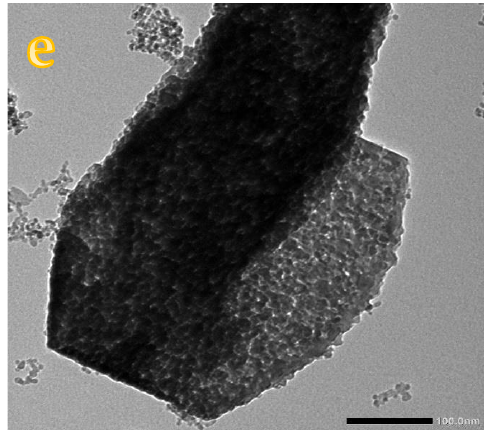
Figure 5. TEM images of ( a ) pure AC, ( b ) 10NFAC, ( c ) 25NFAC, ( d ) 45NFAC, and ( e ) 65 NFAC.